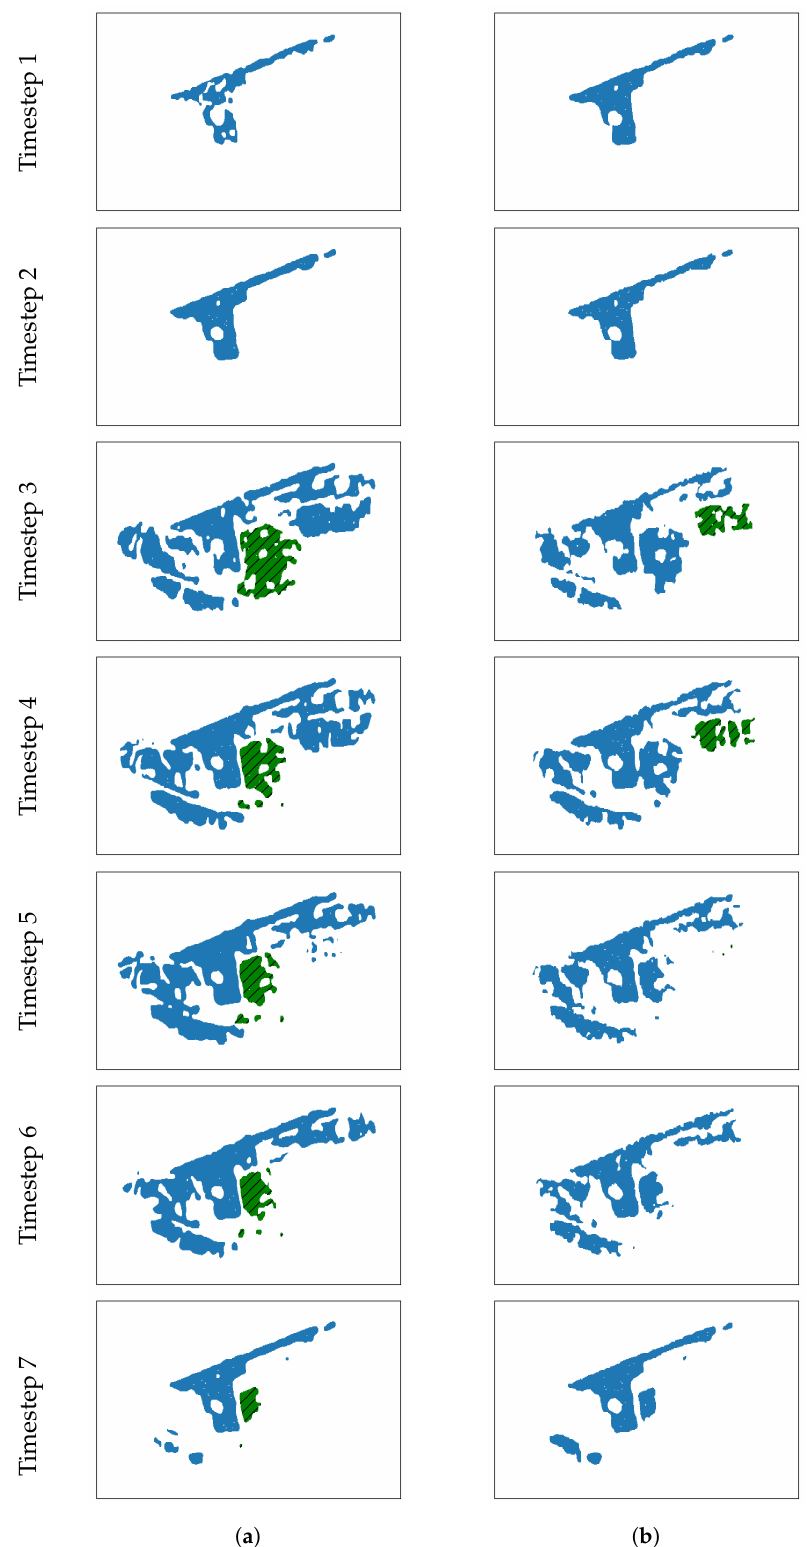
Figure 18. ACM segmentation for VV versus VH polarisation for descending SITS in the dynamic zone. Blue polygons represent permanent entities, and green polygons represent temporary entities. ( a ) Descending VV. ( b ) Descending